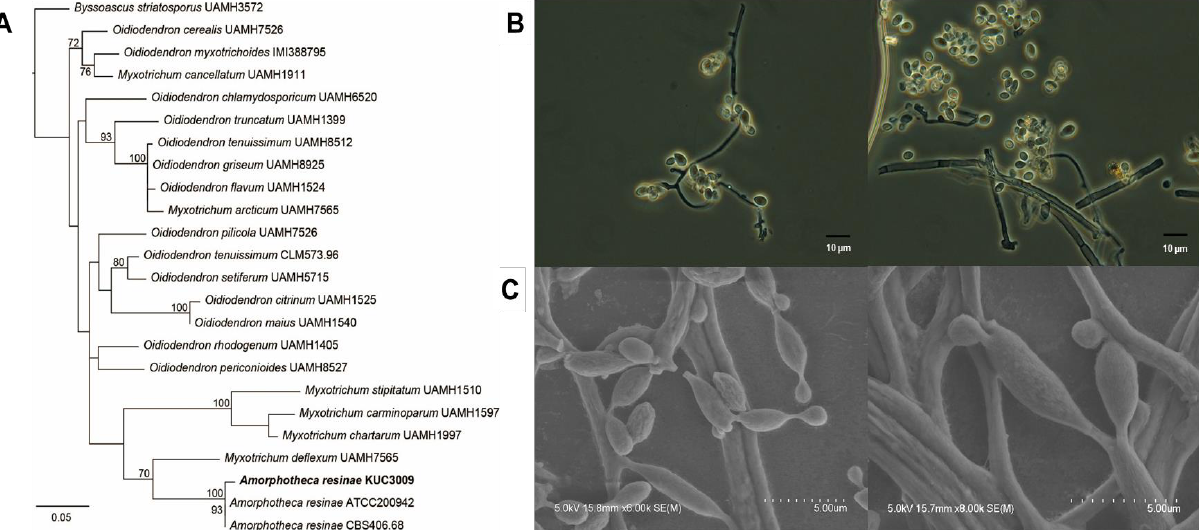
Figure 1. Molecular and morphological characterization of A . resinae KUC3009. ( A ) Phylogenetic tree based on internal transcribed spacer (ITS) sequence alignment generated by maximum-likelihood phylogenetic analysis. All bootstrap support values exceeded 70%. ( B ) Fungal culture imaging with light microscopy and ( C ) field emission-scanning electron microscopy.